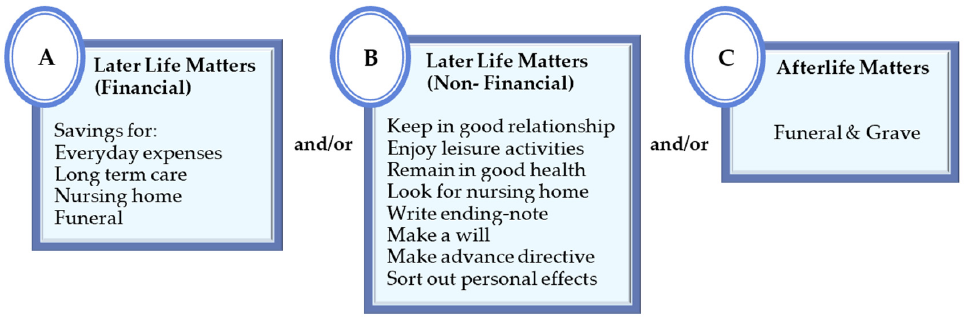
Figure 1. Sh¯ukatsu in the Japanese context. Figure 1. Sh ū katsu in the Japanese context.